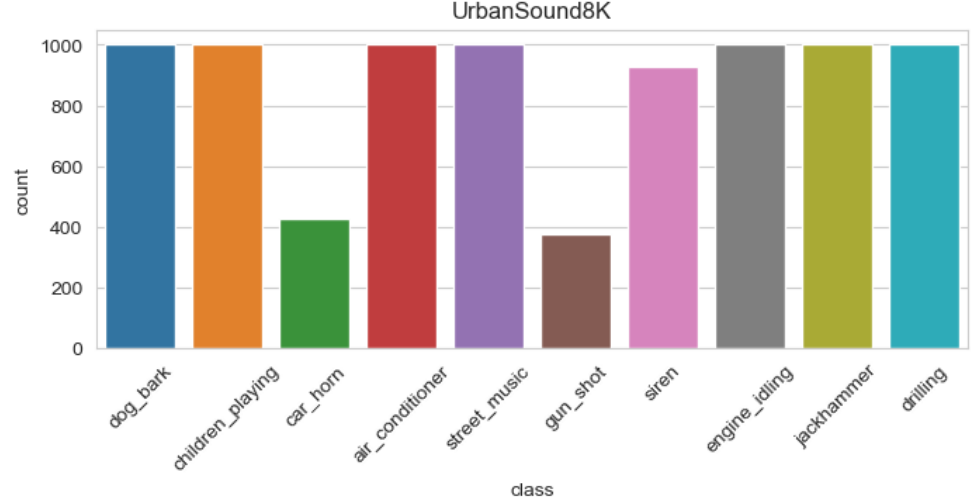
Figure 3. Urbansound8K dataset